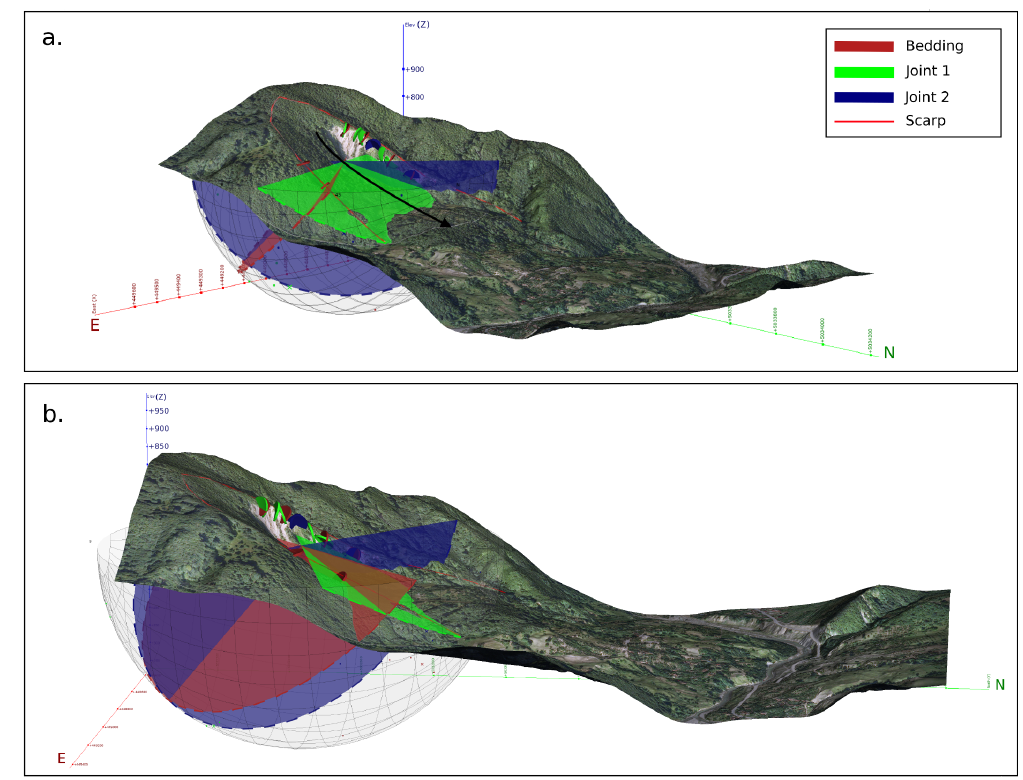
Figure 11. 3D geomodel of the Balta rockslide with a 3D stereonet; ( a ) view towards the SW and ( b ) view towards the W. The coloured planes are the Fisher mean planes and the disks mark the local strike and dip orientation (coordinate system: UTM